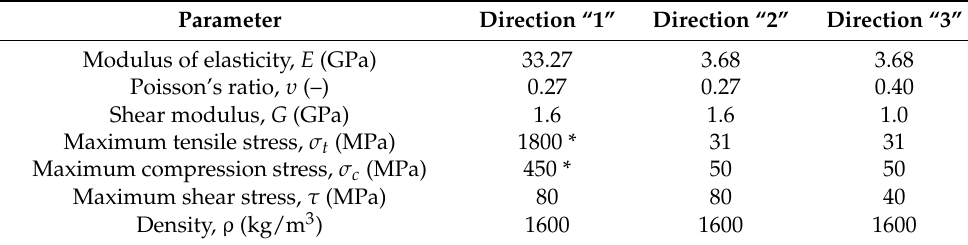
Table 7. The GFRP material model parameters.